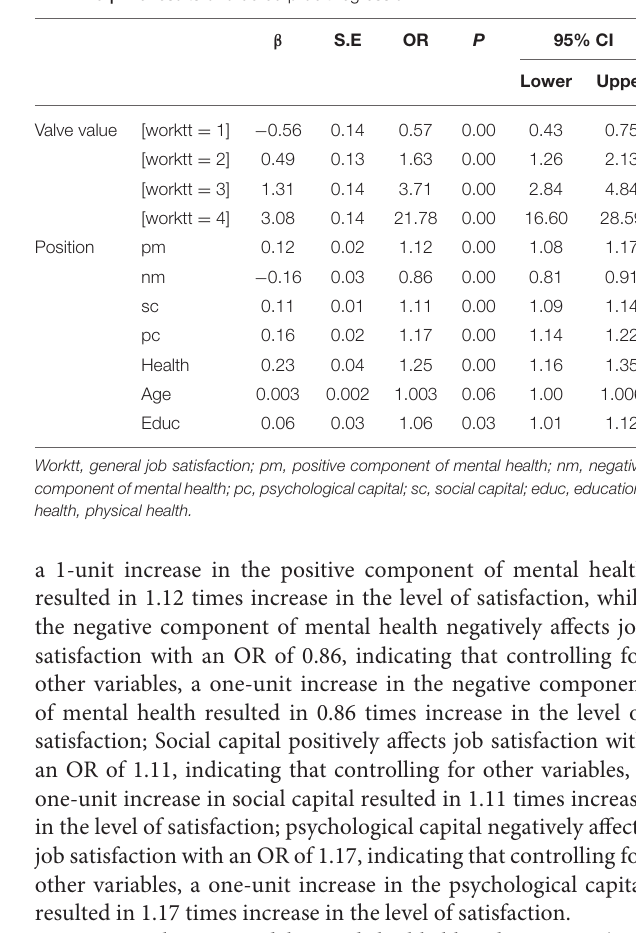
TABLE 5 | The results of ordered probit